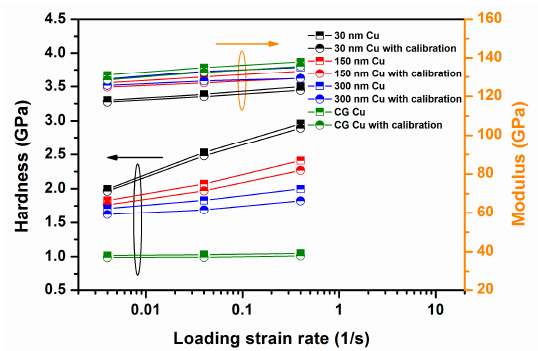
Figure 6. E and H values without and with pile-up corrections as a function of the loading strain rate for 30 nm, 150 nm, 300 nm, and CG Cu.